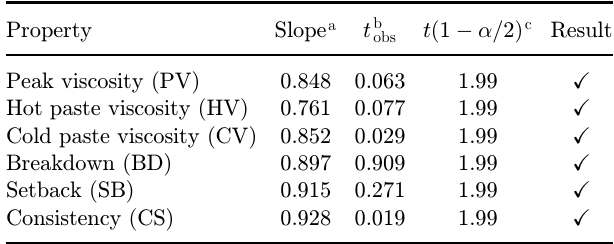
a Slope obtained from the regression of the measured values and the predicted values. b The observed t